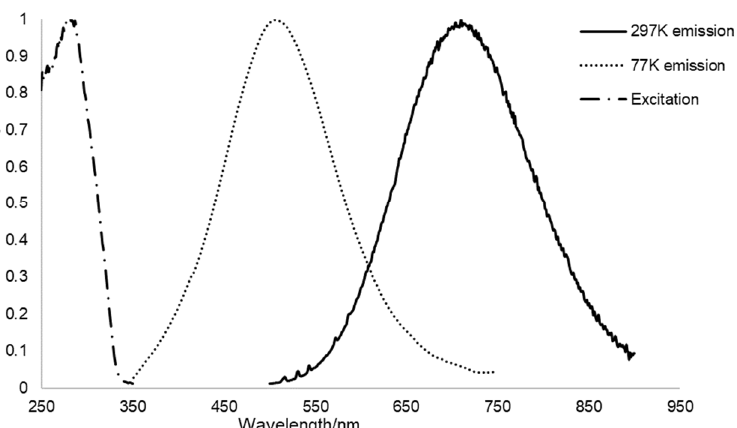
Figure 6. Diffuse reflectance and emission spectra of the solid samples of polymorph α at 297 K and 77 K. The excitation pattern is the same at room temperature and cryogenic temperature. Excitation peak centers at 256 nm, emission peak centers at 510 nm at 77 K, emission peak centers at 710 nm at 297 K. Quantum yield is 15% at 297 K and 60% at 77 K, respectively. The spectra have been normalized to 1 due to reasons of comparability.